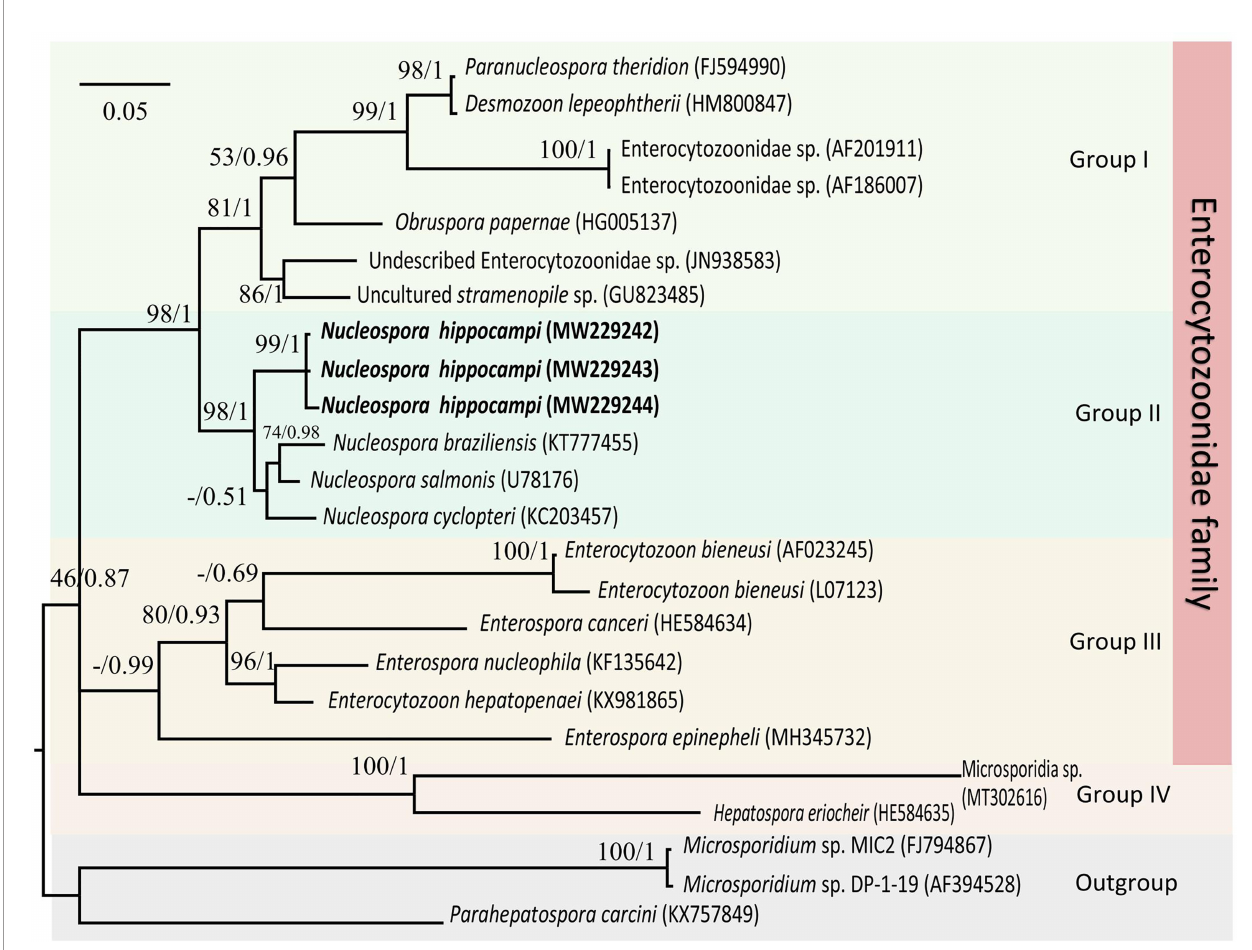
FIGURE 7 | The Maximum likelihood and Bayesian analyses based on SSU rDNA sequences showing the relationship of Nucleospora hippocampi n. sp. and other selected microsporidian species. Parahepatospora carcini (KX757849), Microsporidium sp. MIC2 (FJ794867), and Microsporidium sp. DP-1-19 (AF394528) are used as the out-group. Values at nodes represent Maximum-likelihood bootstrap support percentages (BP)/Bayesian posterior probabilities (PP). The scale bar represents the estimated number of substitutions per nucleotide